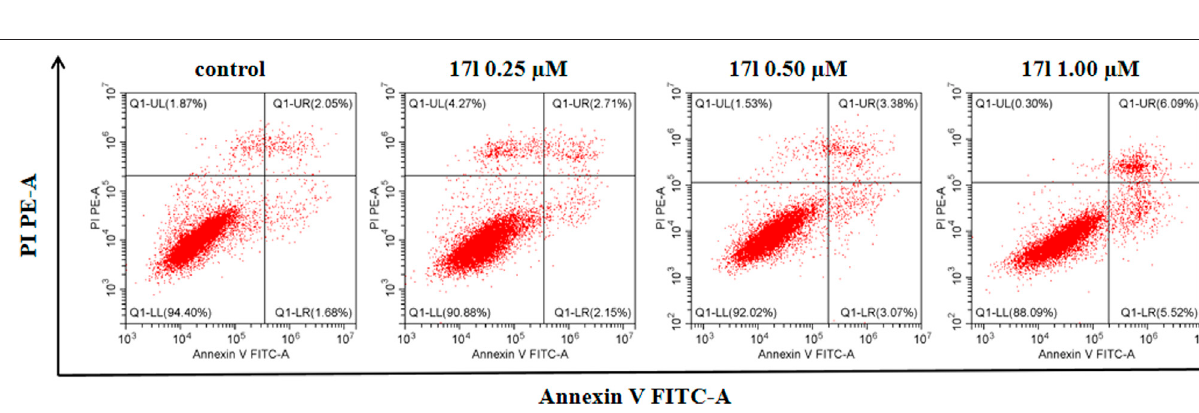
FIGURE 5 | The analyses of compound 17l induces apoptosis of A549 cells.